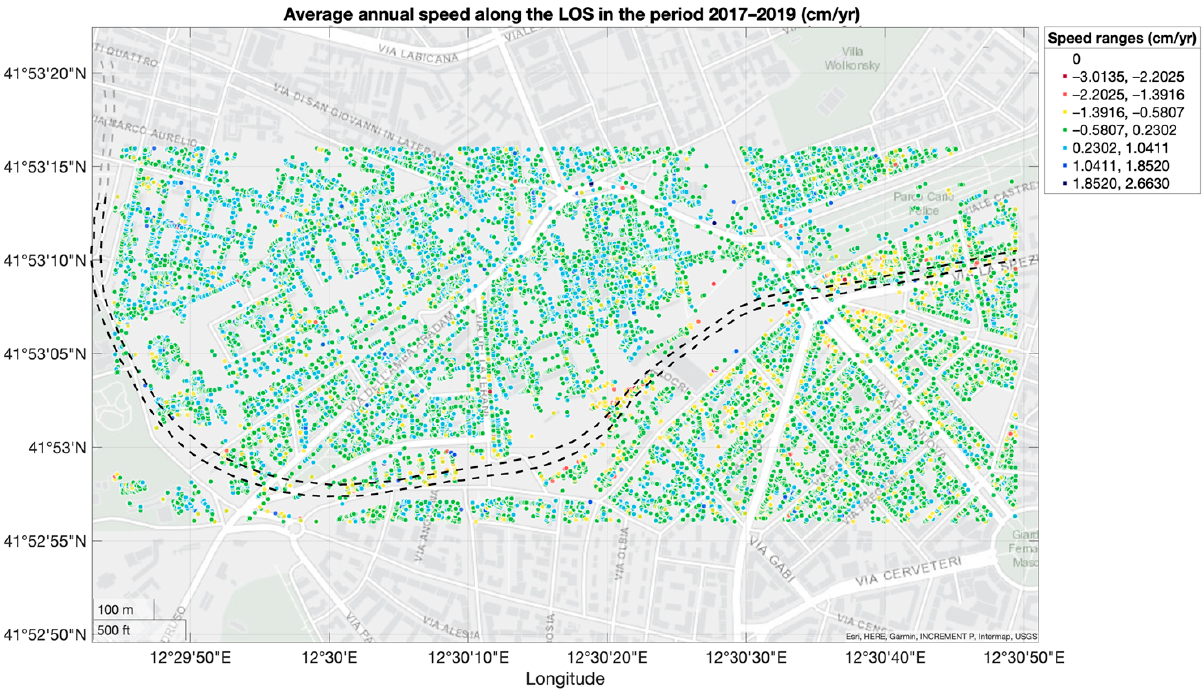
Figure 3. Map showing the dispersion of the average annual velocity along the LOS in the period from 2017 to 2019. The route in black refers to the part already under construction; the route in grey refers to parts not yet built.